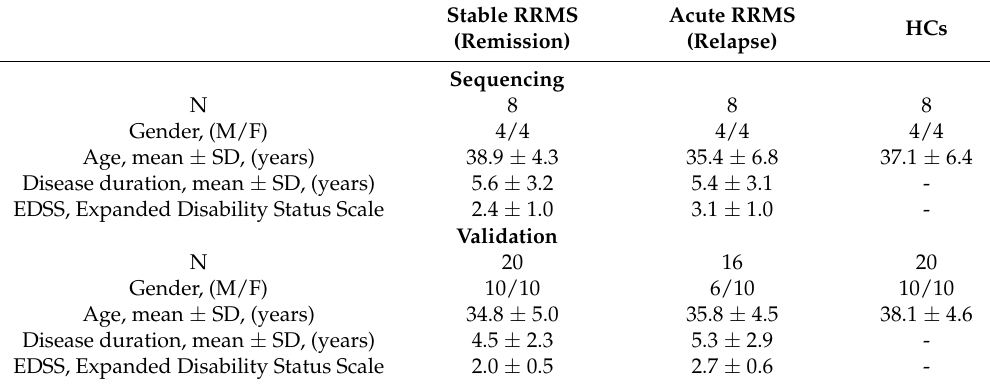
Table 1. Demographic and clinical characteristics of the relapsing-remitting multiple sclerosis (RRMS) patients and healthy controls (HCs) included in the